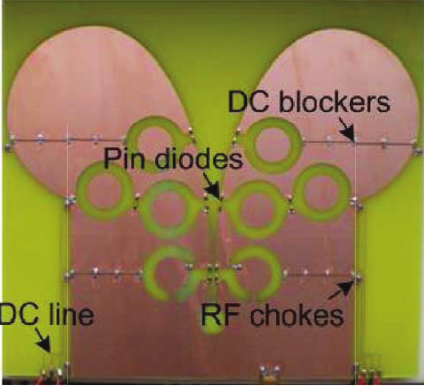
Figure 10: Switchable Vivaldi antenna [19].